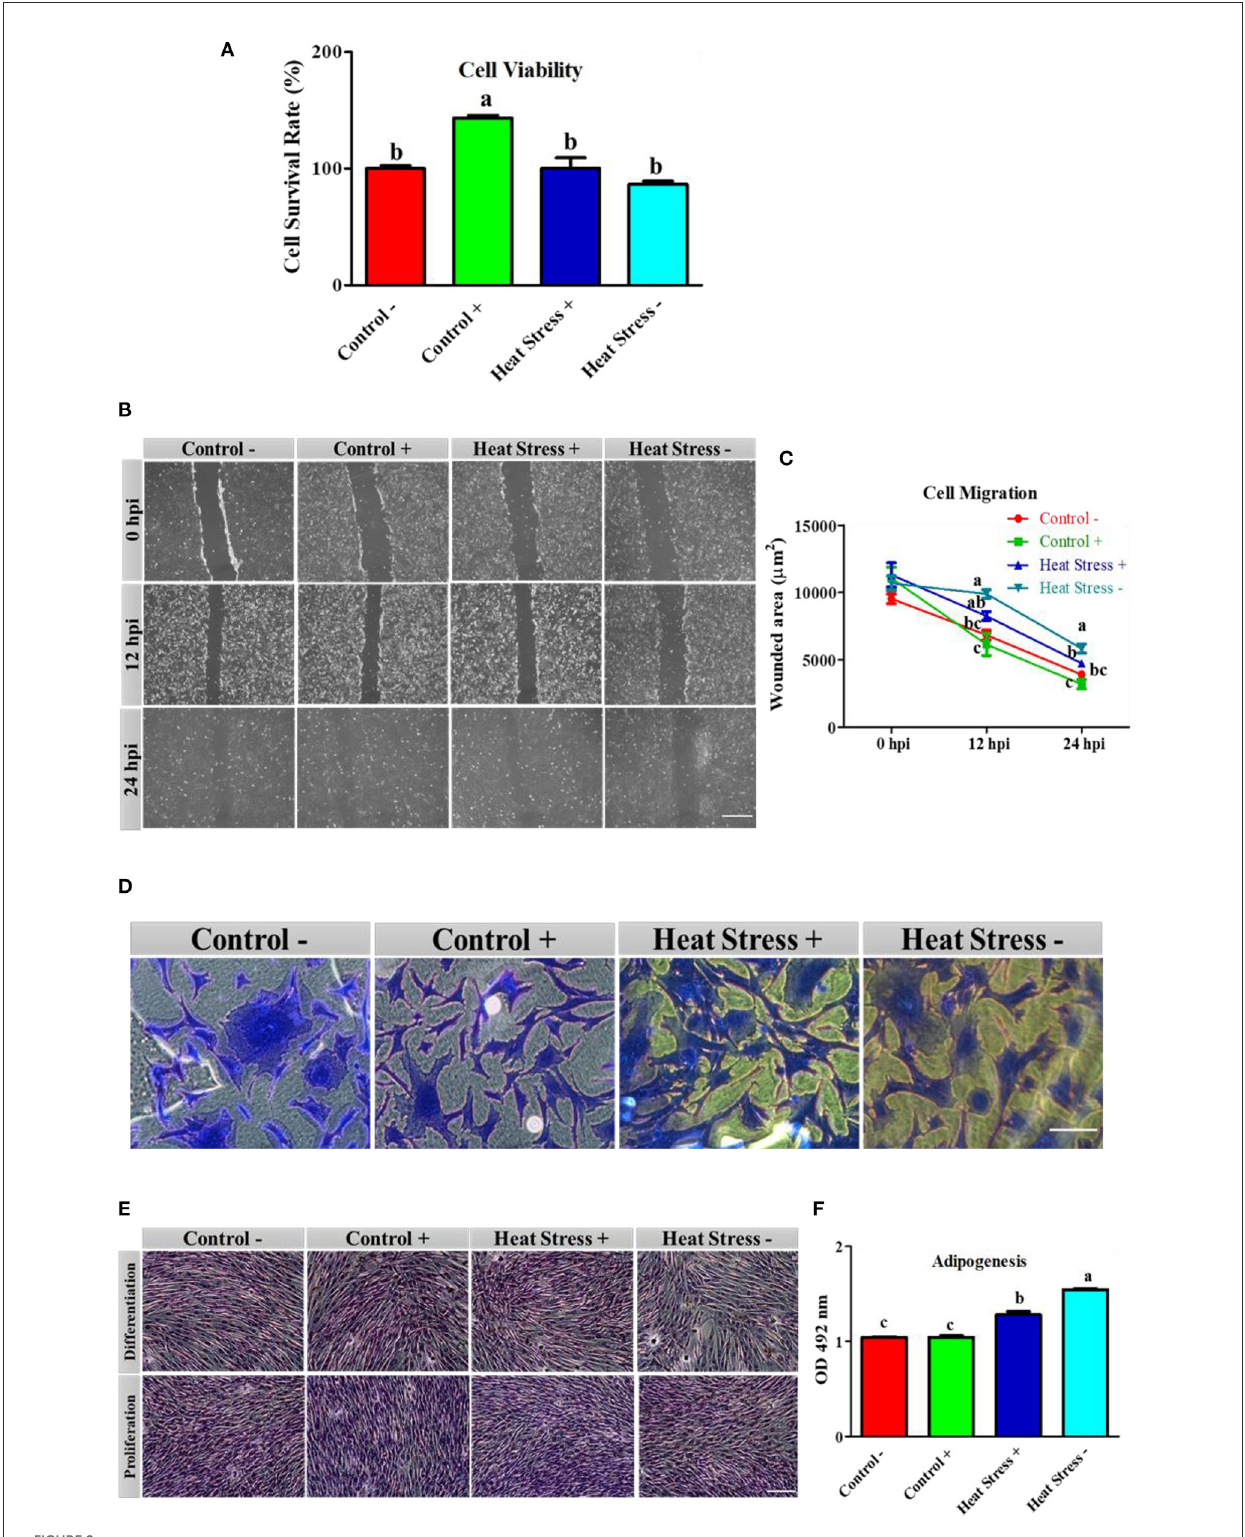
FIGURE2 Effects of COPA3 on stressed fibroblasts’ viability, cytoskeleton structure, and functions. (A) Percentages of fibroblasts’ survivability obtained using the CCK-8 assay. (B) Fibroblasts’ migration activity analysis by wound healing assay; hpi indicates hour post incubation; scale bar = 100 µ m. (C) Wounded area measurement; data represent mean ± SE; a − c different letters indicate significant difference in different groups at specific time periods ( P < 0.05). (D) Coomassie blue stain showing the cytoskeleton shape; scale bar = 20 µ m. (E) Oil Red O (ORO) staining showing the lipid droplets in fibroblasts; scale bar = 100 µ m. (F) Adipogenesis in fibroblasts; data represent mean ± SE; a − c different letters indicate significant difference in different groups ( P < 0.05). Groups are distinguished by temperatures and COPA3 treatment, that is, fibroblasts at 38 ◦ C (Control- group), 38 ◦ C with COPA3 treatment (Control + group), 43 ◦ C with COPA3 treatment (Heat Stress + group), and 43 ◦ C temperature (Heat Stress- group). Each experiment was conducted in four biological replicates ( n =